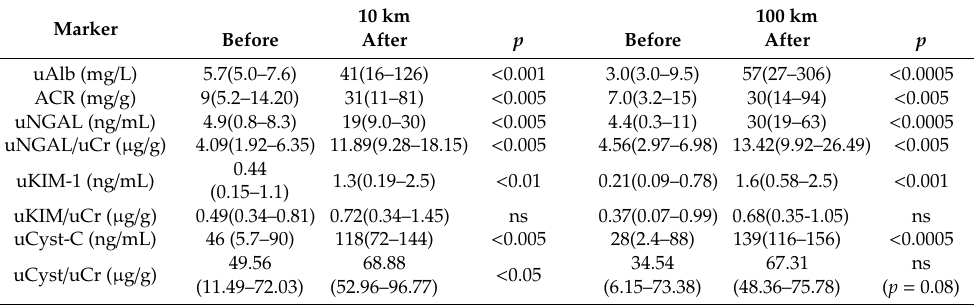
Table 4. Changes in new urinary AKI biomarkers after both races.